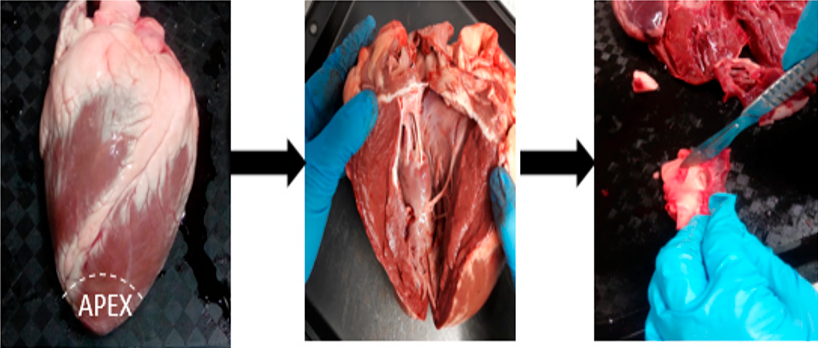
Figure 3. The three stages in the dissection of fossa ovalis.